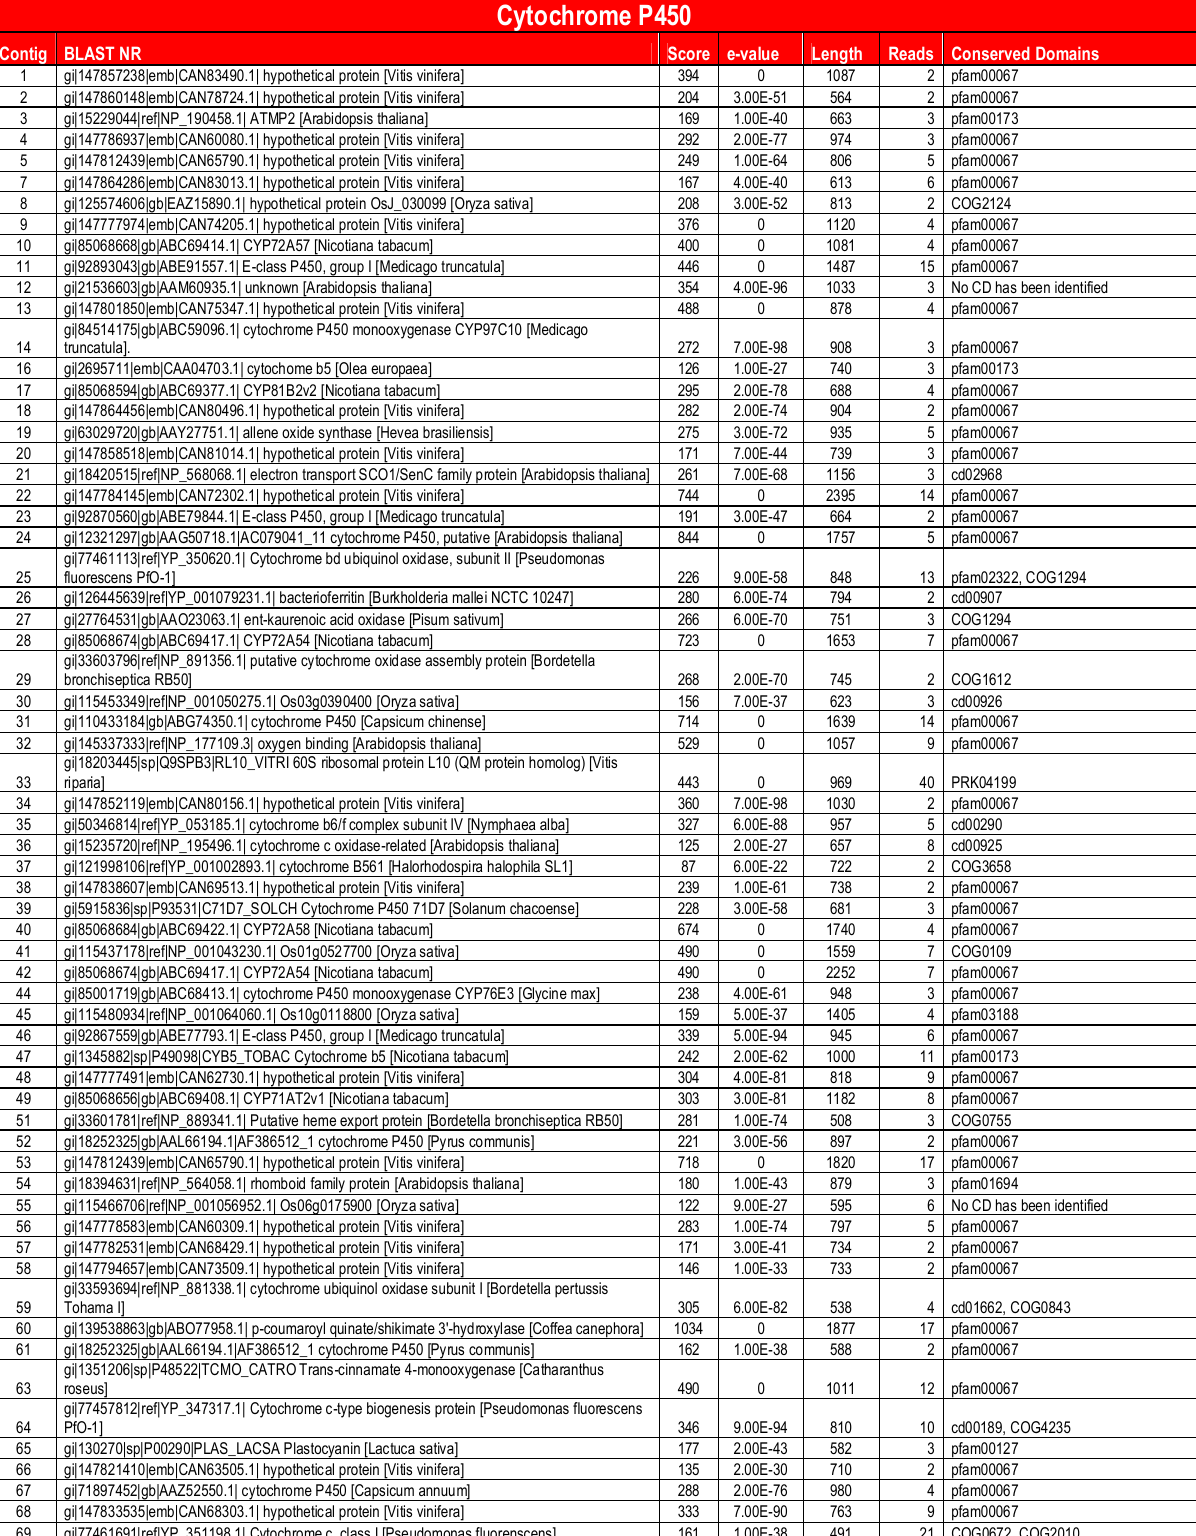
Table S6: EST-Contigs with e-value < e -20 and score > 100 obtained in the Project Cytochrome P450, and their blast hit, score, e-value, size, number of reads, and conserved domains from putative proteins. Cytochrome